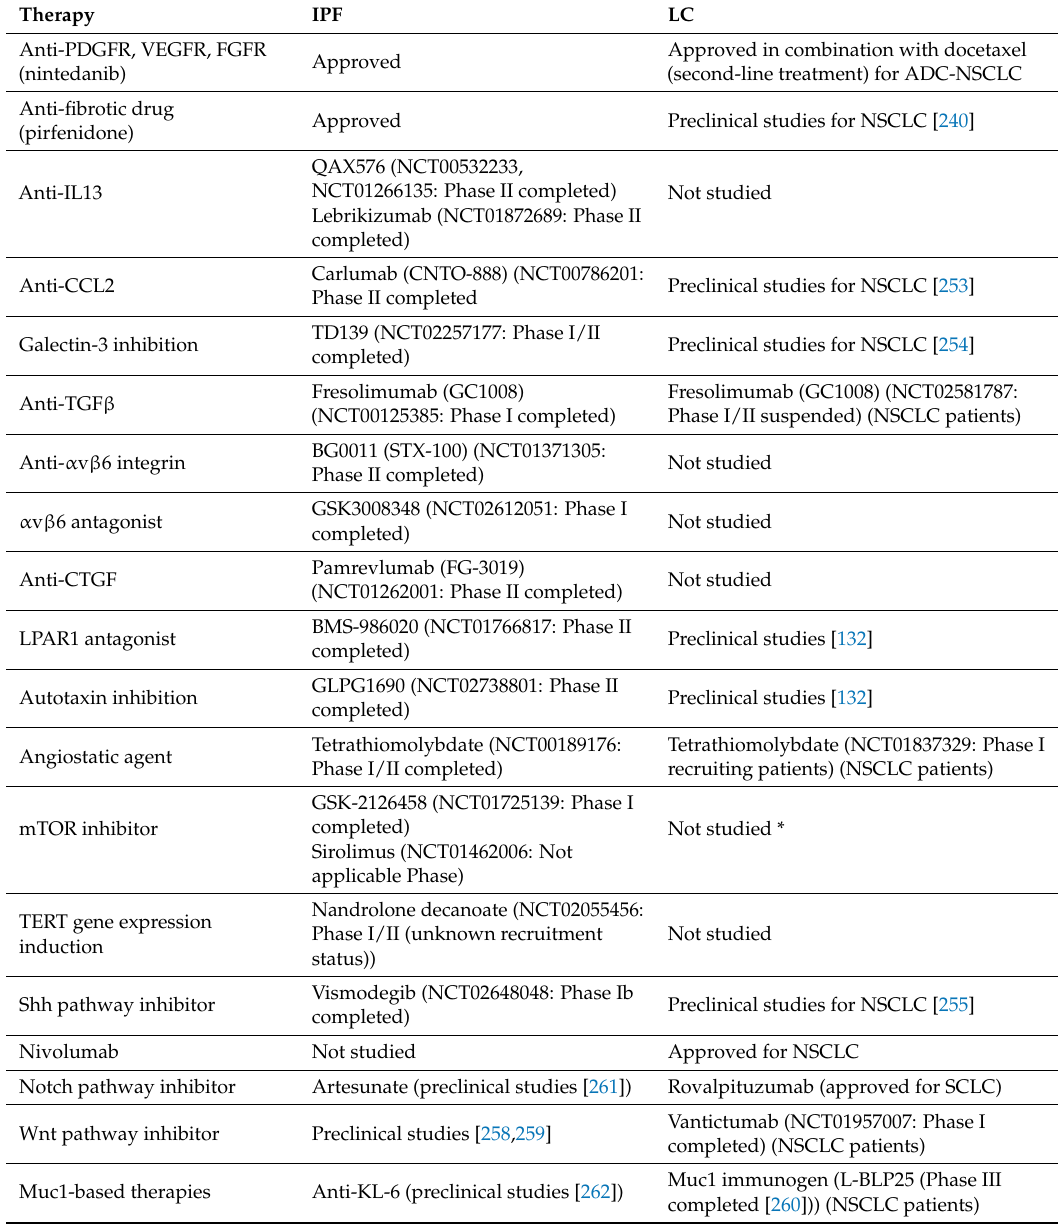
IPF: idiopathic pulmonary fibrosis; LC: lung cancer; NSCLC: non-small cell lung cancer; SCLC: small cell lung cancer; PDGFR: platelet derived growth factor receptor; VEGFR: vascular endothelial growth factor receptor; FGFR: fibroblast growth factor receptor; IL-13: interleukin 13; CCL2: chemokine ligand 2; TGF β : transforming growth factor β ; CTGF: connective tissue growth factor; LPAR1: lysophosphatidic acid receptor type 1; mTOR: mammalian Target of Rapamycin. * (NCT02581787: Phase I/II terminated for subjects with solid advanced